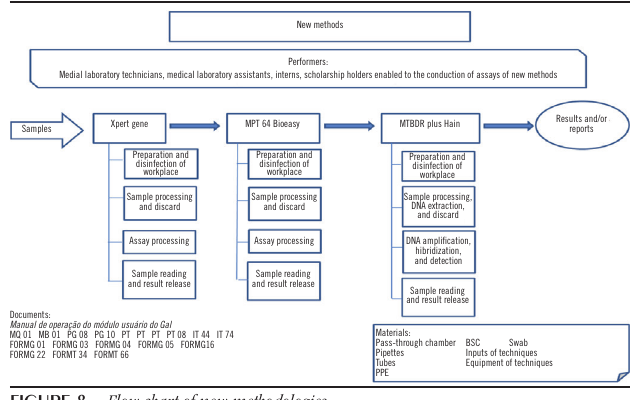
figurE 8 – Flow chart of new methodologies BSC: biological safety cabinet; PPE: personal protection